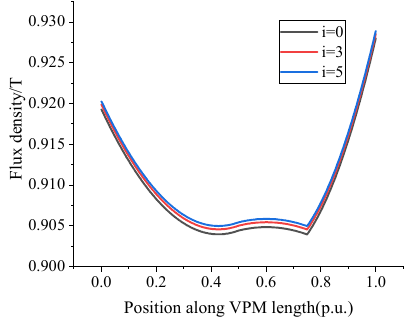
Figure 16. Flux density of VPM.